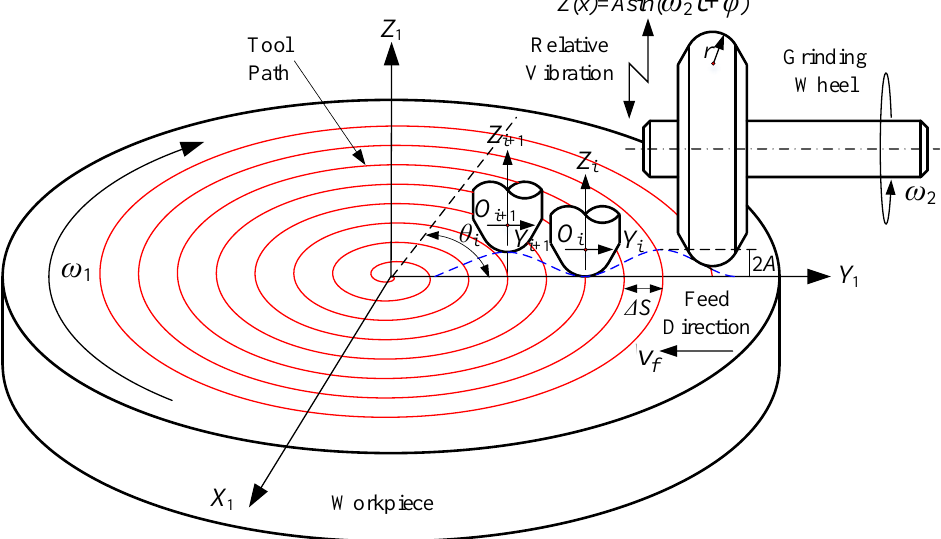
Figure 2. Schematic of locus of the grinding wheel movement in ultra-precision parallel grinding (red solid line indicates tool path and blue dash line represents wheel vibration locus). The ground surface generation strongly depends on the relative travel trajectory of the cutting tool, which is determined by the operation parameters, tool geometry, and movement errors. The most significant of these is the relative motion error of the grinding wheel in the normal direction, which causes the varying engaged depth of the tool. This leads to the increment in surface residual height and degrades the surface roughness. In